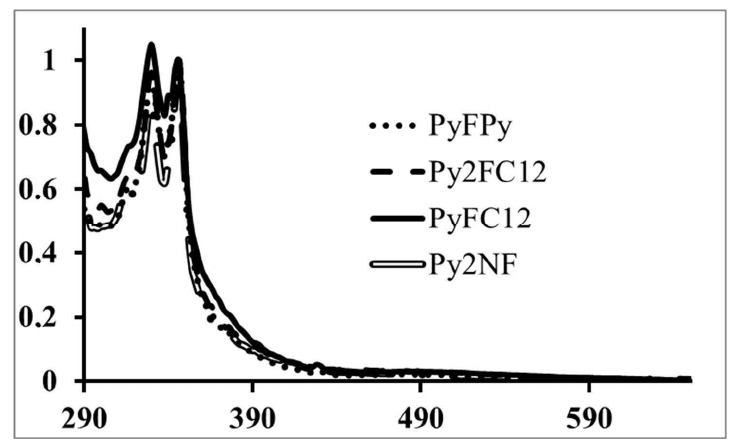
Figure 8. Absorption spectra of pyrene-fullerene C 60 compounds [48].